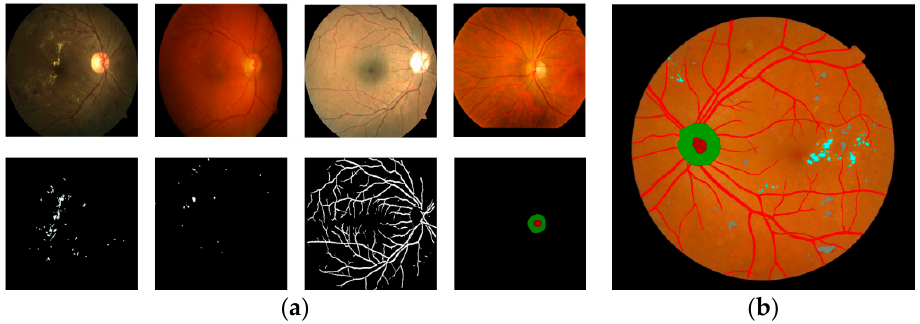
Figure 9. We show the segmentation of fundus images after training (from our own database). ( a ) shows the segmentation of exudates, roth spots, blood vessels, and optic discs (from left to right). ( b ) shows the segmentation of retinal structures and lesions.